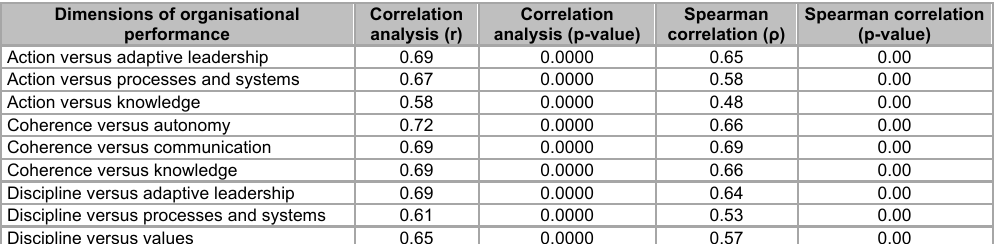
A summary of the correlation analysis (r) and p-values as well as the Spearman correlation coefficient, comparing the dimensions of self-reported organisational performance with the constructs of strategic leadership (n = 188) Dimensions of organisational